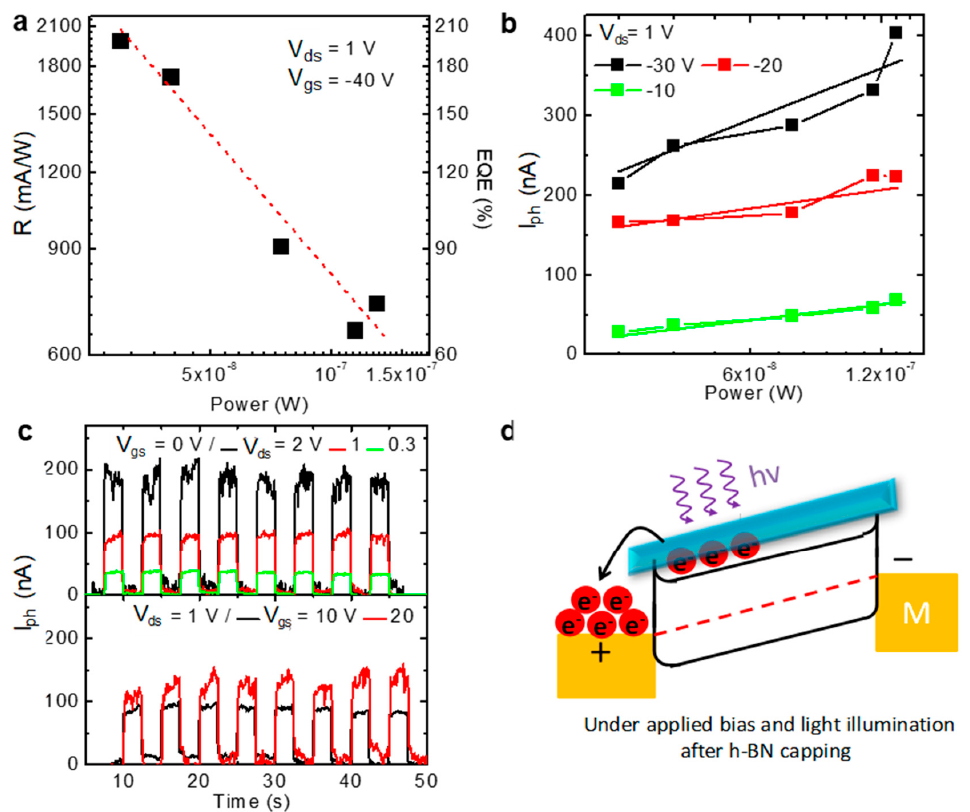
Figure 3. The application of the BP FETs in a photodetector. ( a ) The photoresponsivity of the BP device. ( b ) The photocurrent as a function of the incident illumination power, which shows a monotonic increase in the photocurrent. ( c ) The pulse photocurrent response dependent on the drain and gate bias up to 50 s. ( d ) The fast photocurrent response due to transparent h-BN capping effects on the barrier at the contact junction under bias application with light illumination. Table 1. Comparison of figures of merits for photodetectors based on 2D materials.